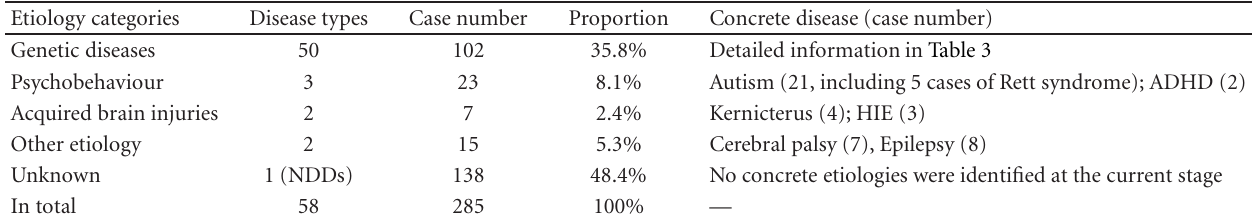
Table 2: Etiology distribution in the whole cohort of NDDs.